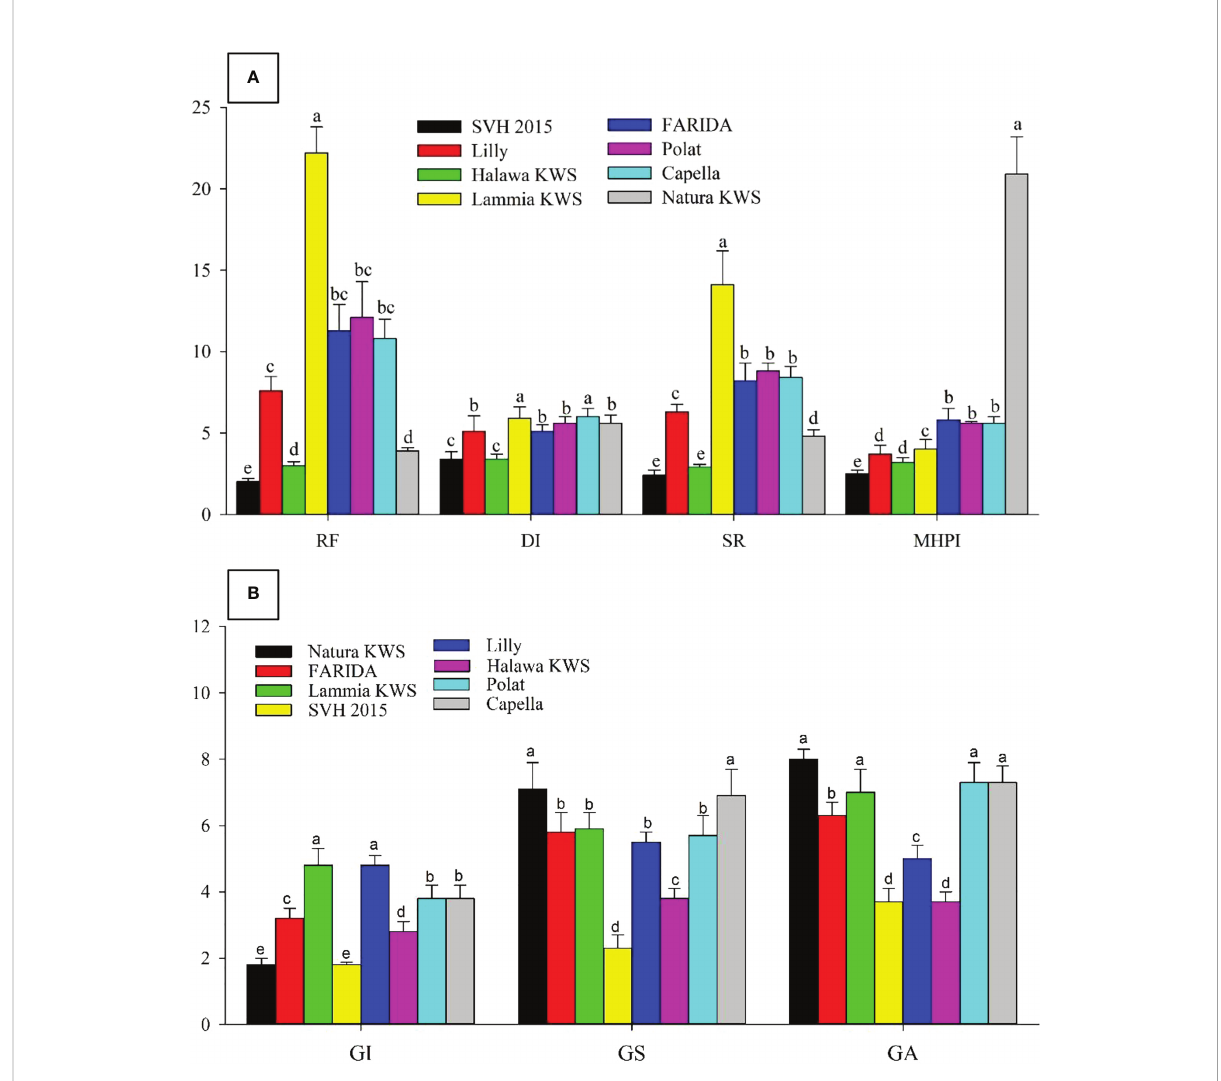
FIGURE 4 Screening sugar beet (Beta vulgaris saccharifera) varieties towards root- knot nematode, Meloidogyne incognita , using seven parameters, including (A) . The reproduction factor (RF), damage index (DI), susceptibility rate (SR), and modi fi ed host parasite index (MHPI); (B) gall index (GI), gall size (GS), and gall area (GA). Mean values followed by different letters are signi fi cantly (P<0.05) different from each other according to Duncan ’ s Multiple Range